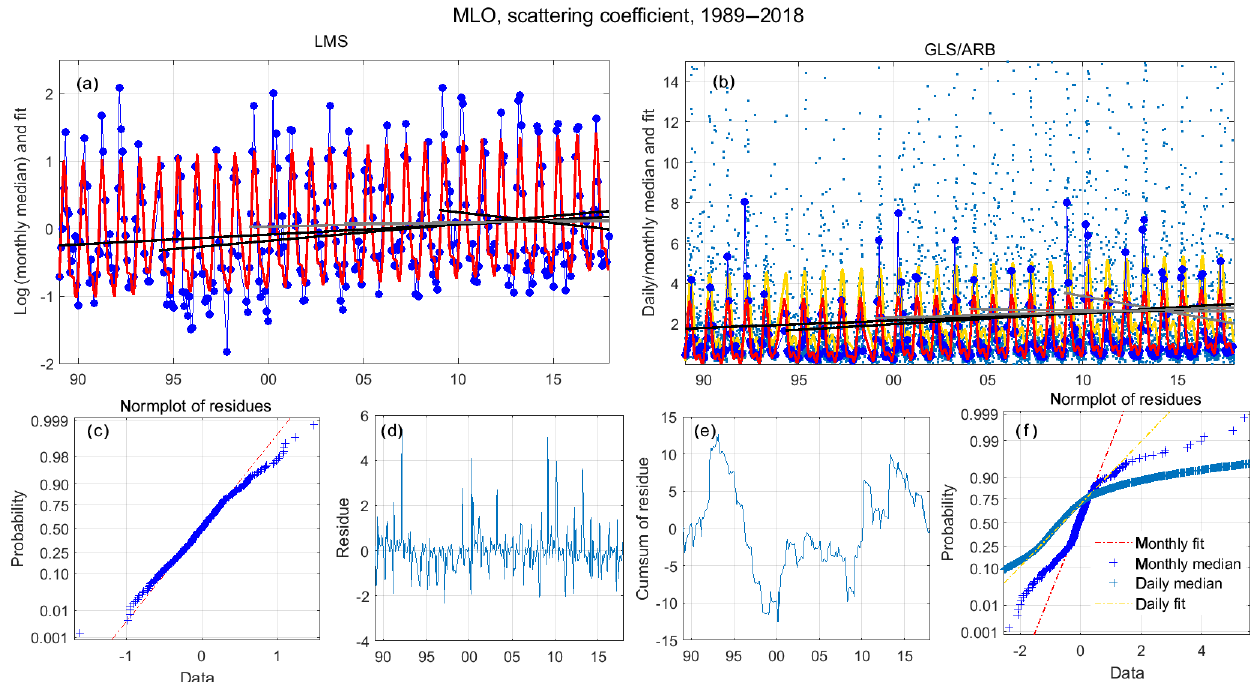
Figure 3. LMS and GLS/ARB results of MLO σ sp : (a) logarithm of the monthly medians (blue circles), LMS fit (red) and the 10- to 30- year slopes (ss slopes are plotted in black and not ss slopes in grey), (b) daily medians (light blue dots) and their GLS/ARB fit (orange line), monthly medians (blue circles) and their GLS/ARB fit (red) and the 10- to 30-year slopes, (c) normplot of LMS residues, (d) monthly medians of the GLS/ARB residues, (e) cumulative summation of monthly median GLS/ARB residues and (f) normplot of GLS/ARB residues for daily medians (light blue crosses and orange line) and monthly medians (blue crosses and red